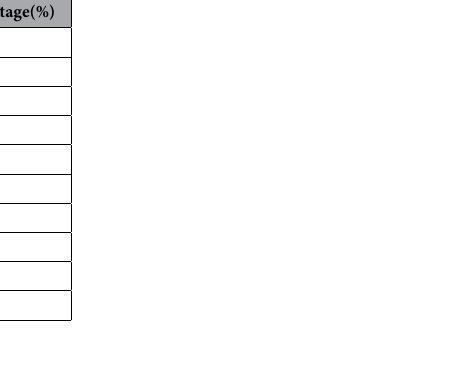
Table 4. The demographic information of Study 1b.